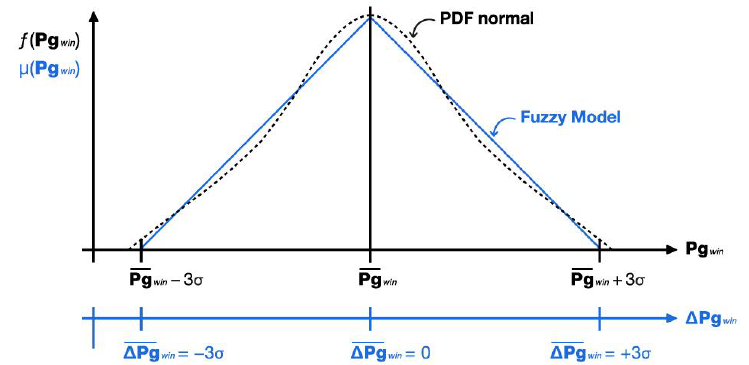
Figure 2. Probability Density Function (PDF) and fuzzy triangular model for wind and solar energy sources.